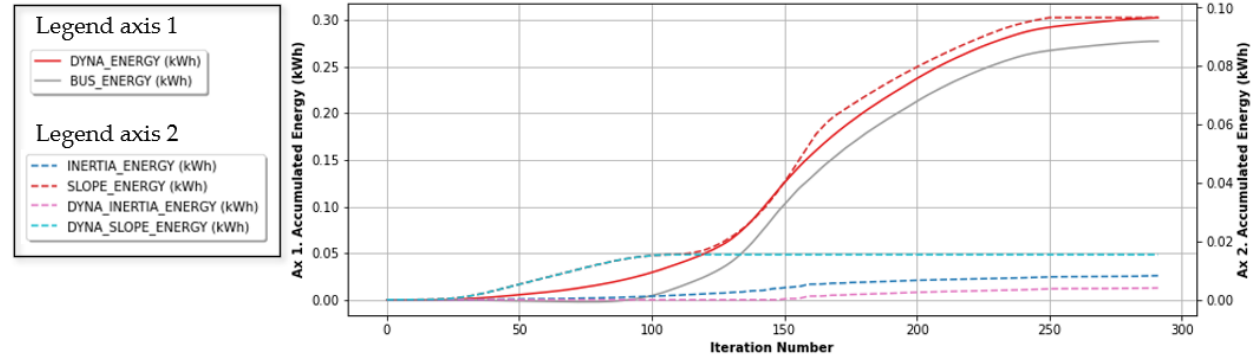
Figure 12. Calculated and measured energies entire route.